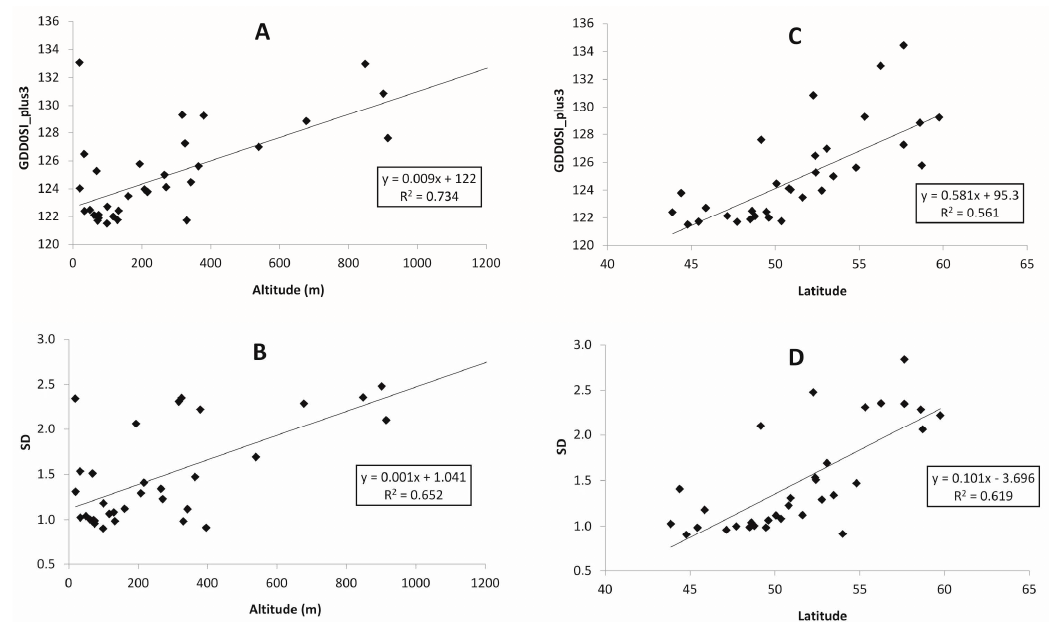
Figure 5. Dependence of Sensitivity Index for growing degree days with 0 °C threshold (GDD0SI) and its standard deviation (SD) for a GDD0 +3 scenario on altitude and latitude for continental locations in the Russian Far East for the period 1966–2017: ( A , B ) altitude (m), ( C , D ) latitude.